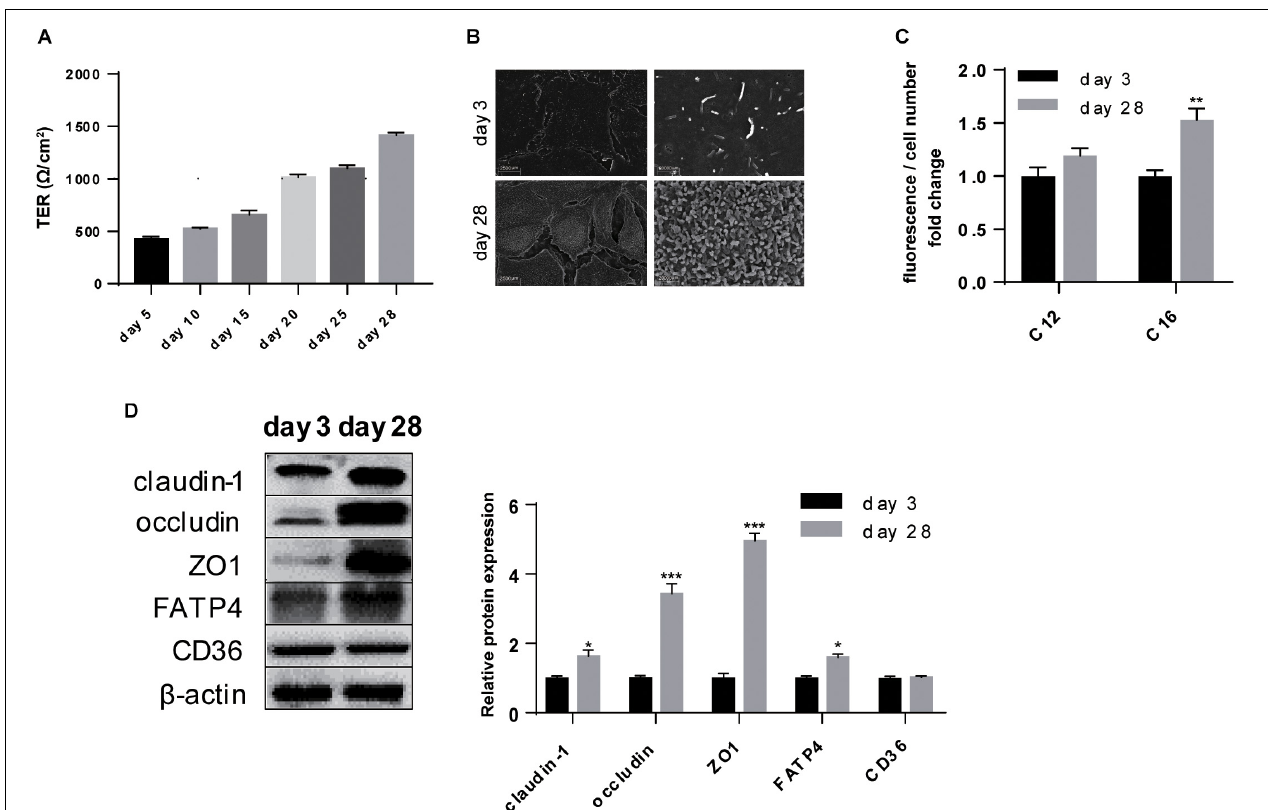
FIGURE 2 | Polarization of IPEC-J2 cell line promoted intestinal barrier and LCFA uptake ability. (A) Time-dependent TER measurement of IPEC-J2 cells growing in Transwells. (B) SEM visualization of cells grown on day 3 and day 28. Scale bars, 2,500 µ m (left) and 20,000 µ m (right). (C) Uptake of Bodipy-labeled C12:0 and C16:0 normalized by cell counting. (D) Western-blot analysis of TJs claudin-1, occludin, ZO1; FA uptake associated proteins FATP4 and CD36. Data are presented as mean ± standard error. ∗ P < 0.05, ∗∗ P < 0.01, and ∗∗∗ P < 0.001.